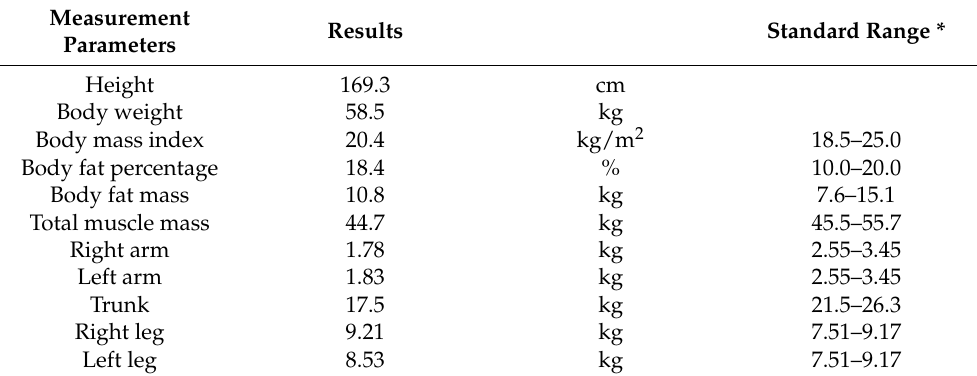
Table 2. Body composition